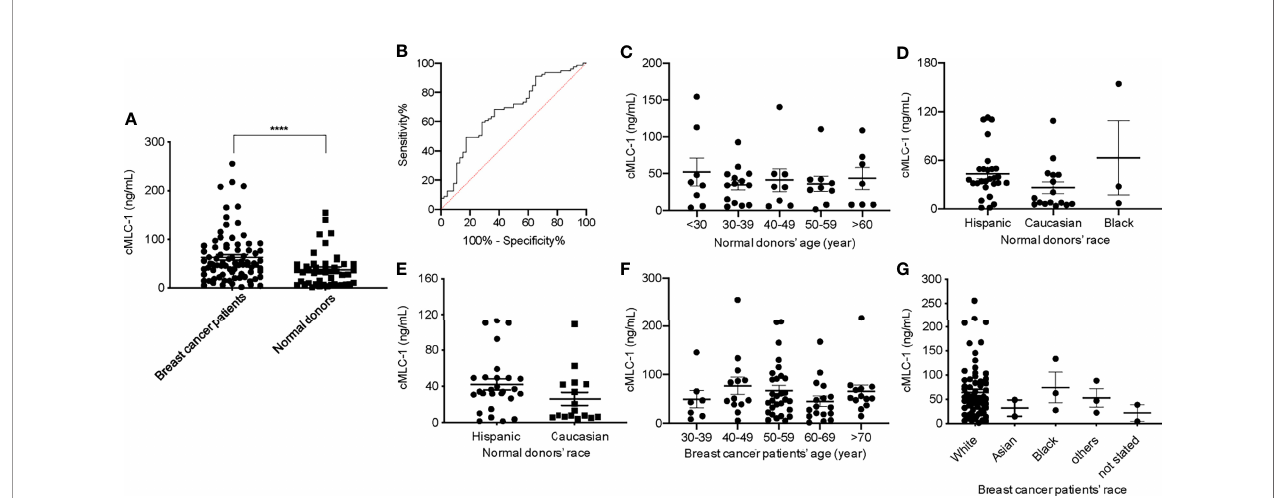
FIGURE 2 | Plasma cMLC-1 level was signi fi cantly higher in breast cancer patients than normal healthy women. Each plasma sample was 1:10 diluted and tested twice in duplicate to determine cMLC-1 concentration by ELISA. The mean ± SD of cMLC-1 in breast cancer patients (n=79) vs. normal donors (n=46) is shown. The Mann-Whitney U test was used to analyze the difference. **** p =0.0006 (A) . The receiver operator characteristic (ROC) graph of the logistic regression result was calculated by GraphPad Prism 8 to determine the relationship between sensitivity and speci fi city. The cutoff of cMLC-1 at (or higher) 49.55 ng/mL was chosen to reach a sensitivity of 59.49% (B) . To determine the impact of age and race factors on cMLC-1 level, plasma samples from all normal donors of different ages and races (n=46) were analyzed and compared. The one-way ANOVA was used for differences among all indicated groups of age ( p =0.8630) (C) and of race ( p =0.138) (D) . To ensure the data were accurate, cMLC-1 between “ Hispanic ” and “ Caucasian ” were analyzed by the Mann-Whitney U test ( p =0.0988) (E) without the “ black ” group given its small size of samples. Plasma samples from all patients of different ages and races (n=79) were analyzed and compared. The one-way ANOVA was used to test differences among all indicated groups of age ( p =0.4767) (F) and of race ( p =0.7079) (G) .